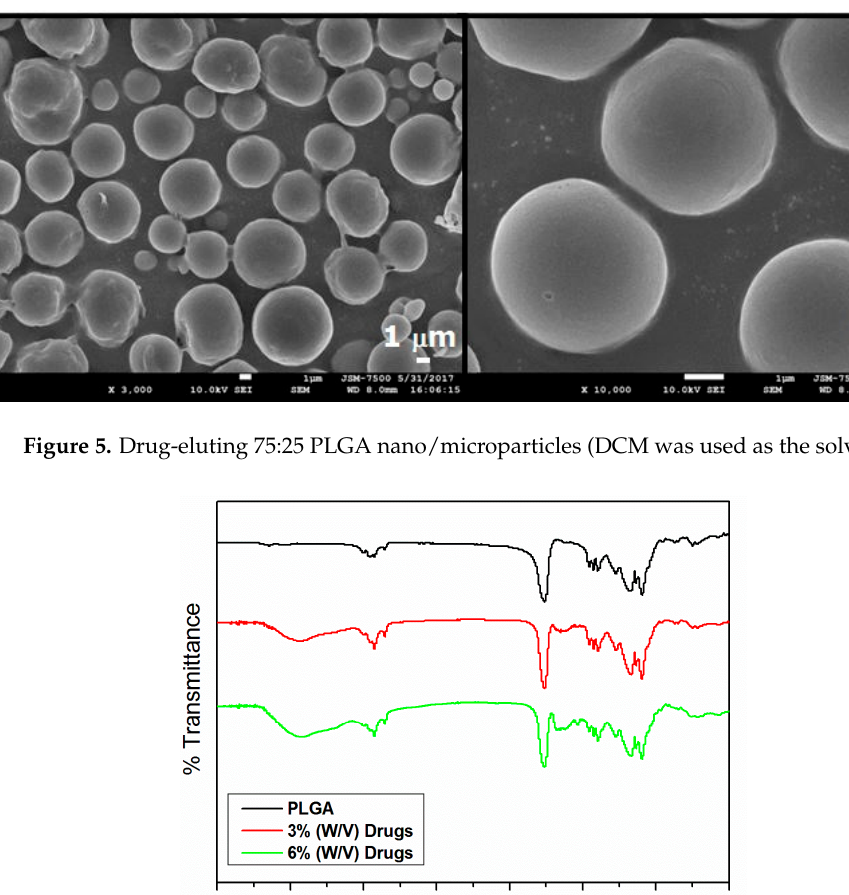
Figure 4. Drug-eluting 50:50 PLGA nano/microparticles fabricated using different solvents: ( A ) dichloromethane (DCM); ( B ) chloroform (CHF); ( C ) 1,1,1,3,3,3-hexafluoro-2-propanol (HFIP).